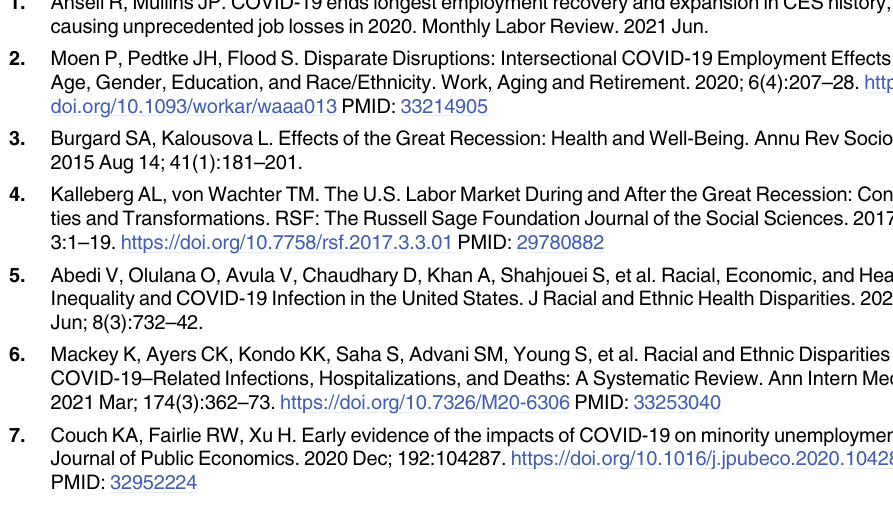
S4 Table. Fixed-effects models predicting men’s full-time employment by immigrant sta- tus, race/ethnicity and parenthood status in 2020 relative to 2019. Notes: � p < .05, �� p < .01, ��� p < .001. S5 Table. Fixed-effects models predicting men’s full-time employment by immigrant sta- tus, race/ethnicity and employment status of other household members in 2020 relative